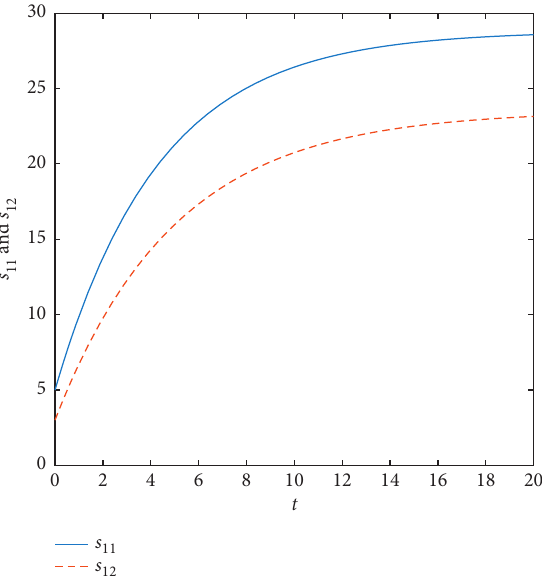
Figure 6: The pollution abatement investment trajectory of the upstream region under noncooperation.